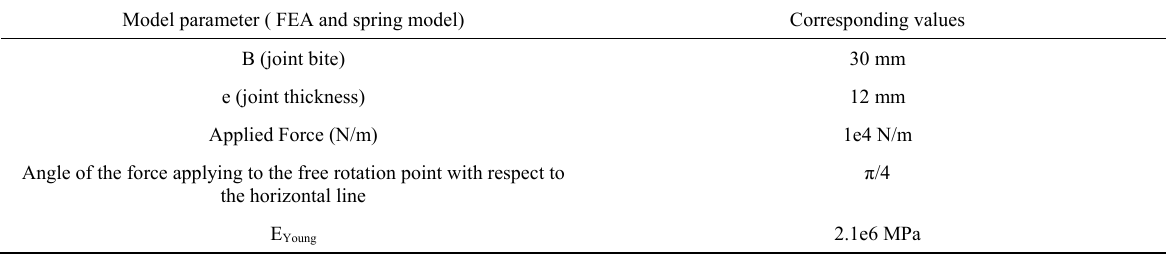
Table 4: Parameters use of the modeling of a silicone joint having a force applied to a free rotation point located at the upper right part of the joint. Model parameter ( FEA and spring model) Corresponding values